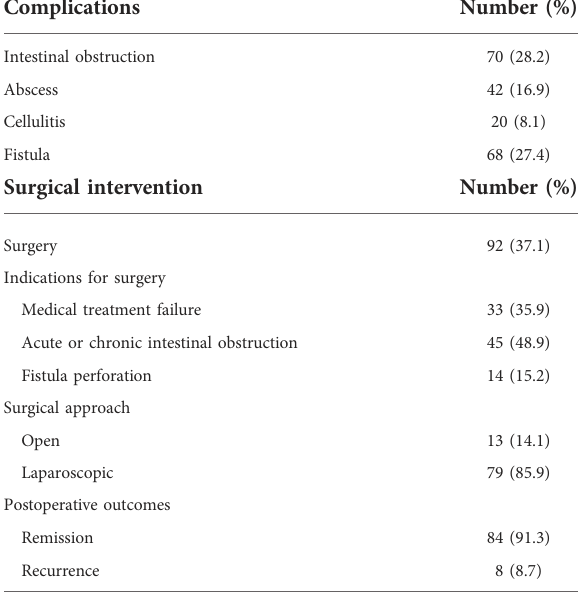
TABLE 2 Complications and clinical outcomes in CD patients.